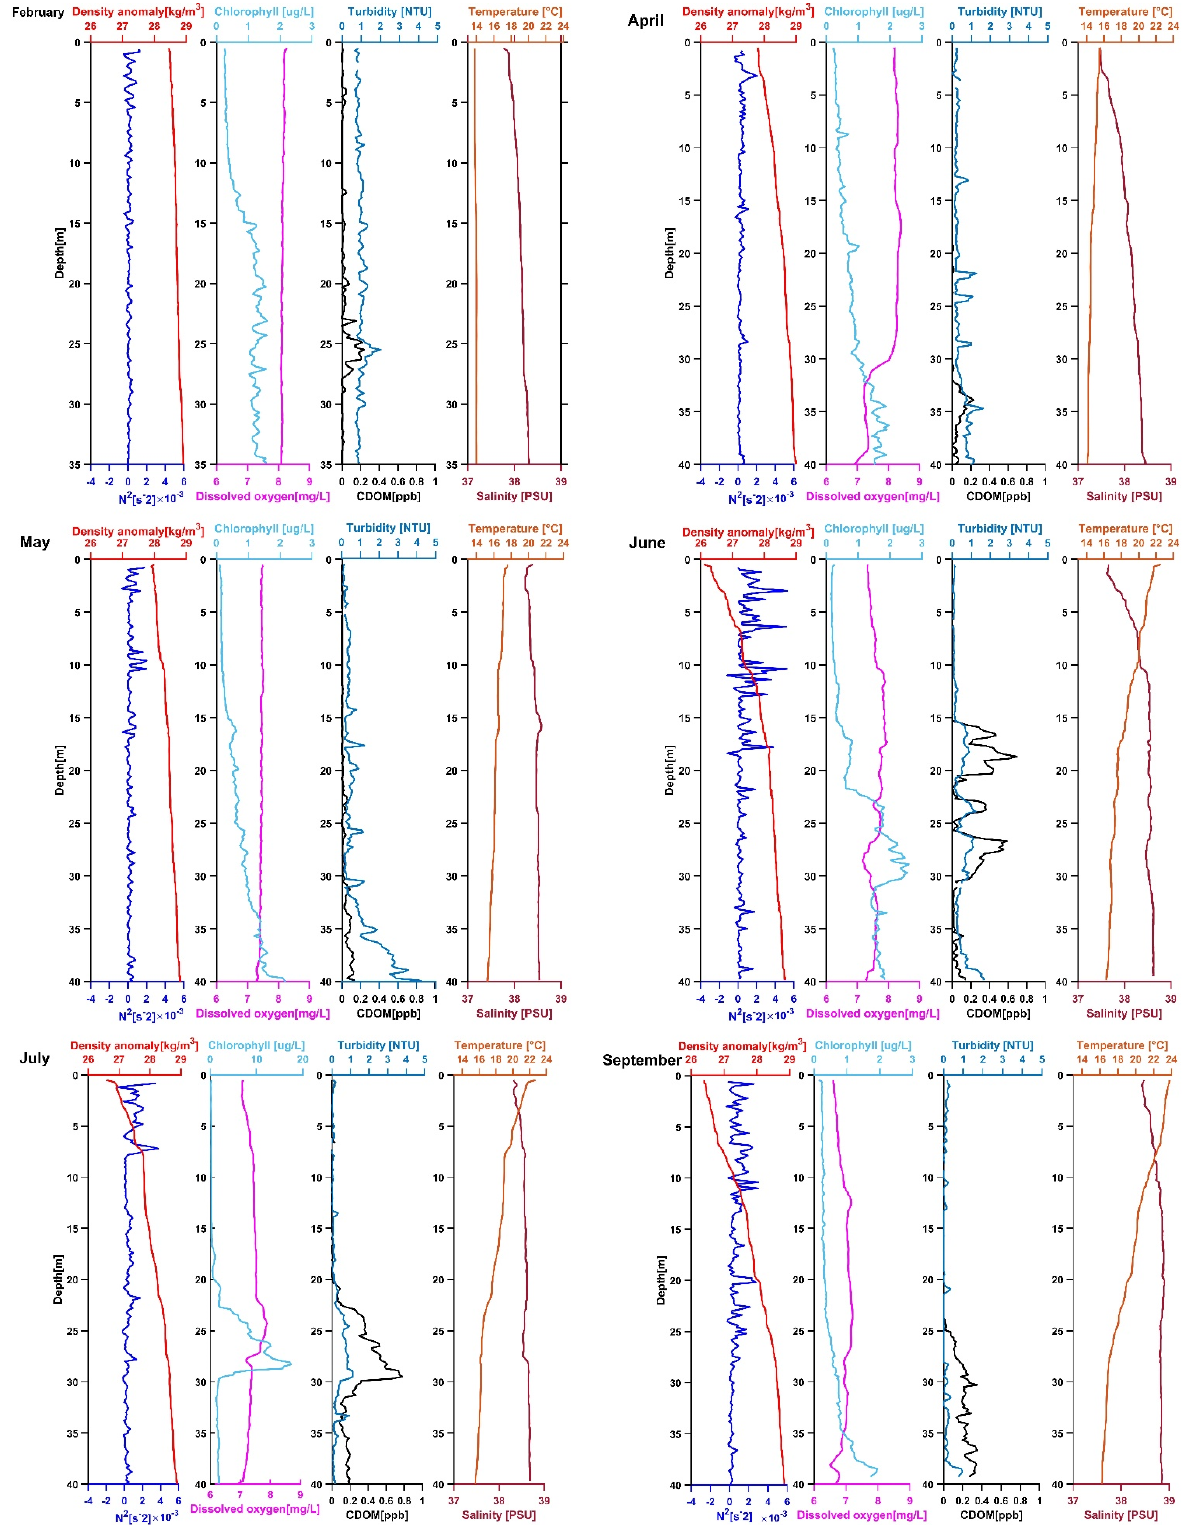
Figure 2. Vertical profiles sampled during 2020 at location 1. The measured parameters are density anomaly (red line), buoyancy frequency (blue line), chlorophyll (light blue line), dissolved oxygen (magenta line), turbidity (green line), CDOM (black line), temperature (orange line), and salinity (brown line).